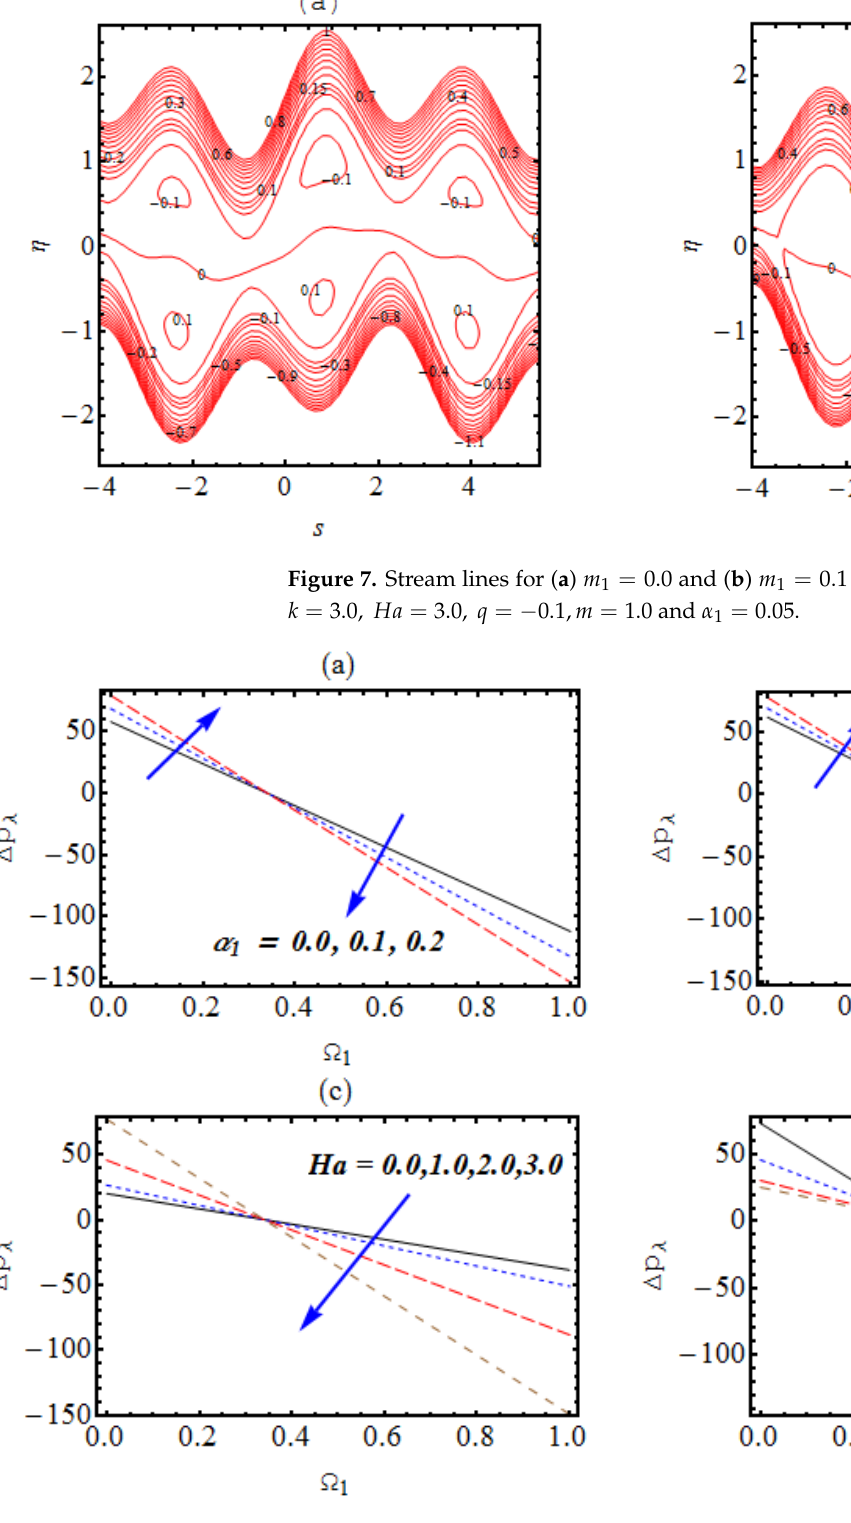
Figure 8. ( a – d ): ( a ) Change in pressure due to α 1 , ( b ) change in pressure due to α 2 , ( c ) change in pressure due to Ha ( d ) change in pressure due to m